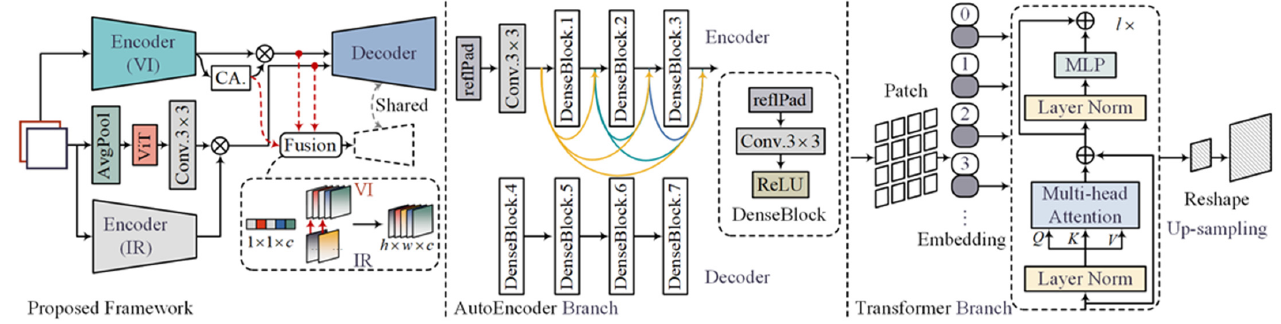
Figure 4. Proposed fusion framework (CA: channel attention; h: height; w: weight; c: channel).